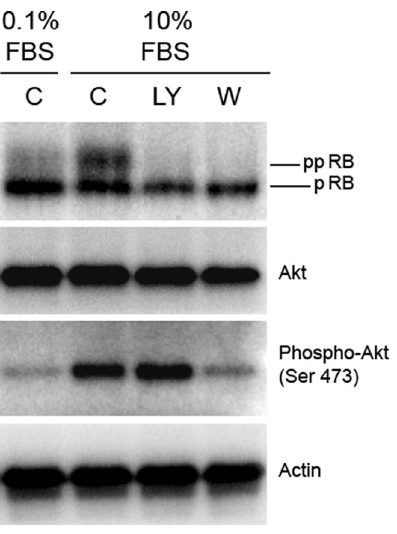
Figure 5. PI3-kinase inhibition prevents retinoblastoma hyper- phosphorylation in confluent PASMC exposed to high serum concentrations. Human PASMC attained confluence in low (0.2%) serum and were maintained in low serum for seven days. Cells were then exposed to 0.1% or 5% serum in the presence or absence of LY294002 or wortmannin and cell lysates harvested 24 hours later for protein analysis. Representative Western blot is shown. [pRB: hypopho- sphorylated retinoblastoma; ppRB: hyperphosphorylated retinoblasto-